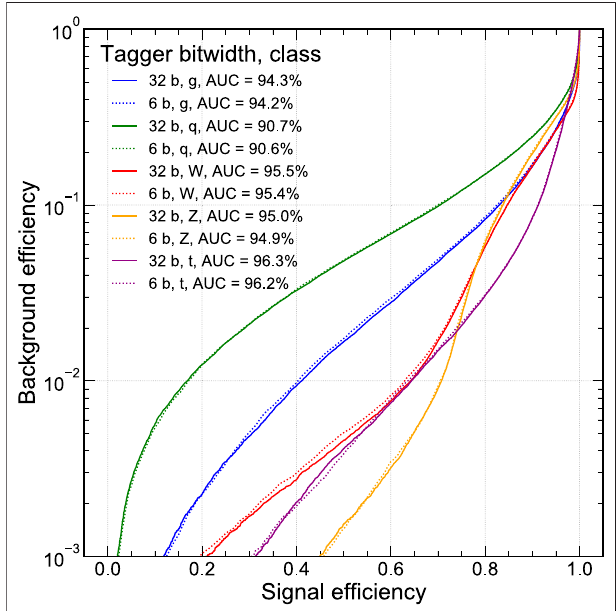
FIGURE 3 | The ROC curve for each signal jet type class where the backgroundaretheotherfourclasses.Curvesarepresentedfortheunpruned 32-bit fl oating point classi fi er (solid lines) and 6-bit scaled integer models (dashedlines). Allmodels aretrained withbatchnormalization layersand L 1